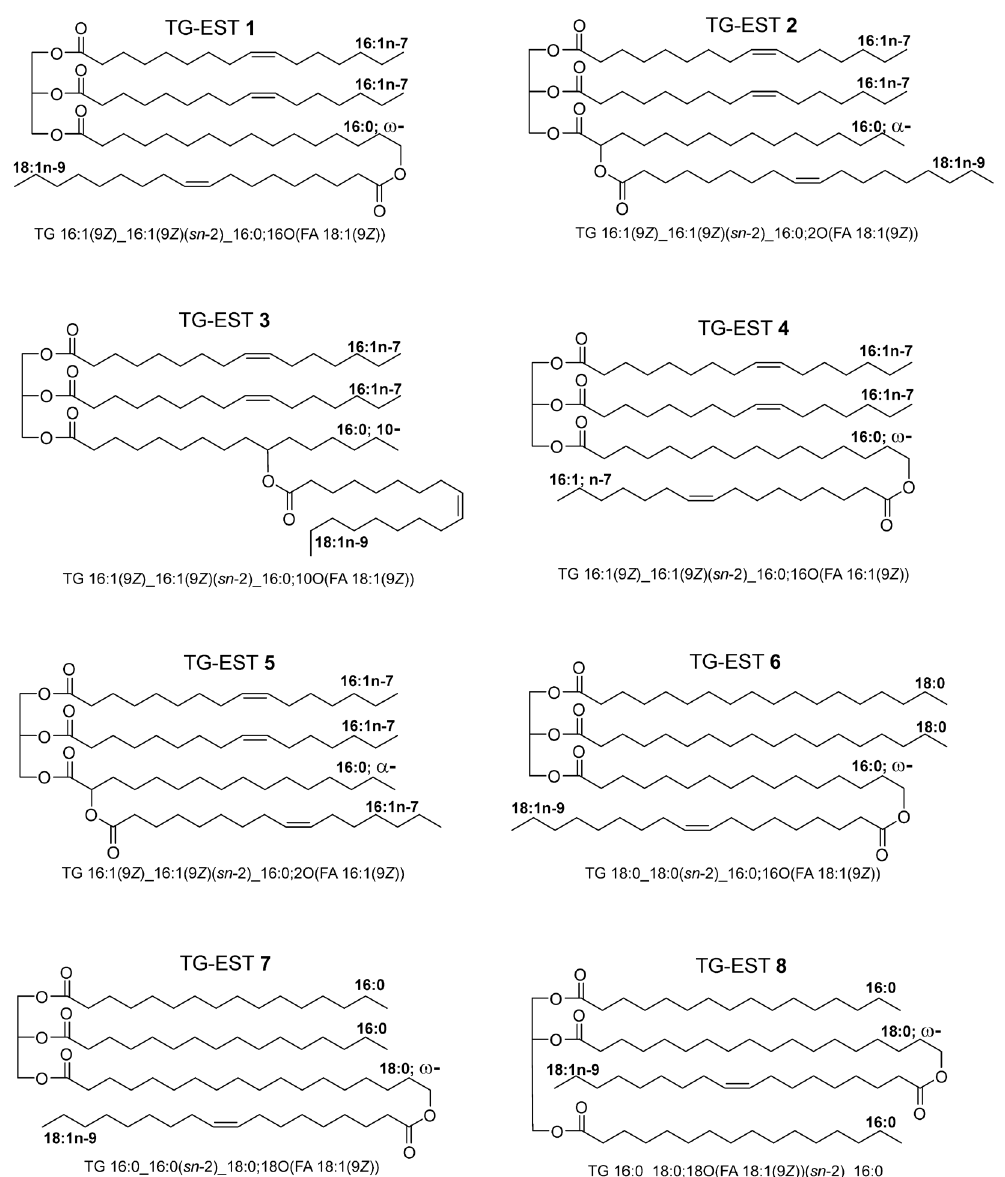
Figure 1. Studied structures of TG-EST 1 – 8 . Lipid nomenclature according to Liebisch et al. [52].